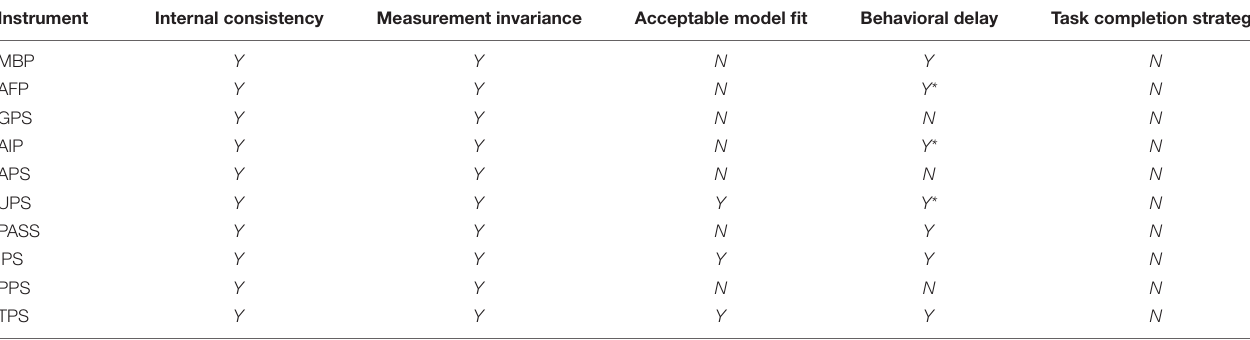
TABLE 6 | Summary of the results of psychometric analyses and tests of concurrent and predictive validity. Instrument Internal